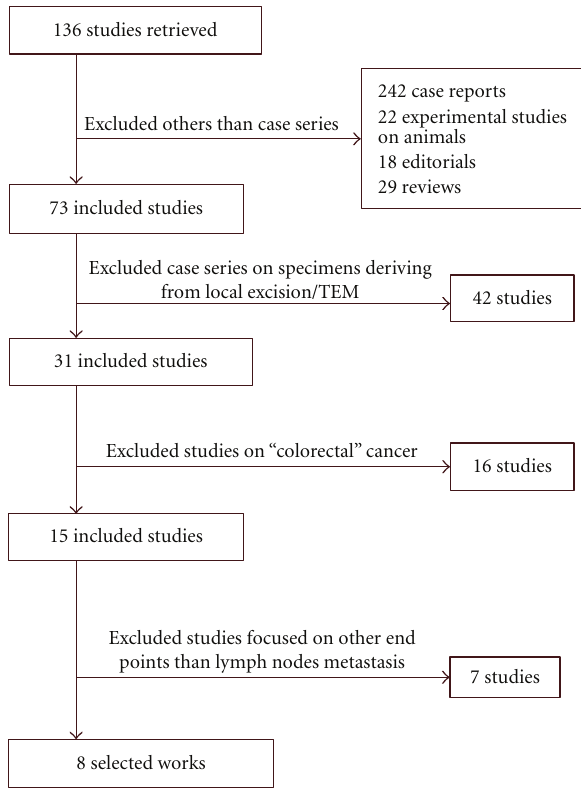
Figure 1: Quorum flowchart of the literature